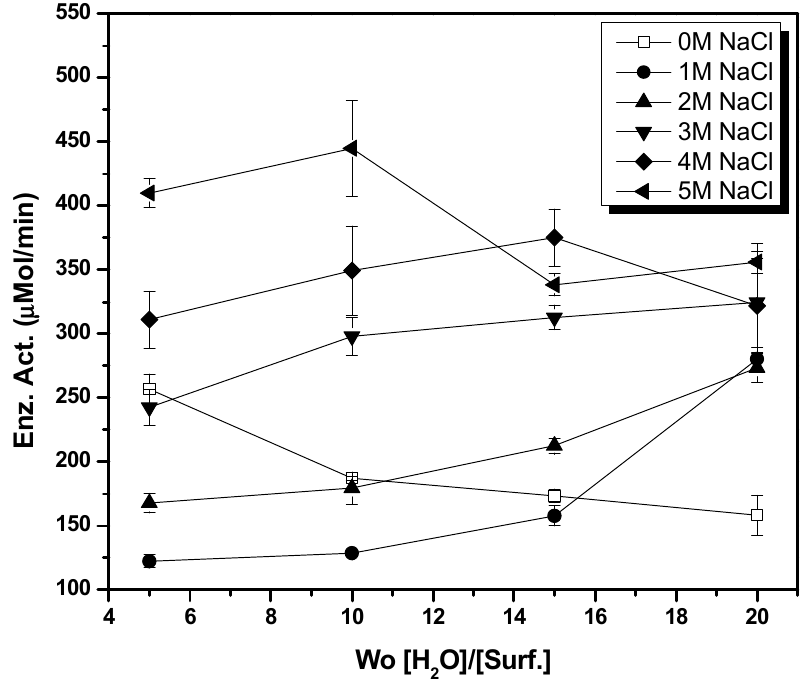
Figure 3. Influence of NaCl and Wo on the enzymatic activity of butyl oleate synthesis reactions with CalB. Reaction conditions: AOT/H 2 O/Isooctane reverse micellar system at 30 °C.